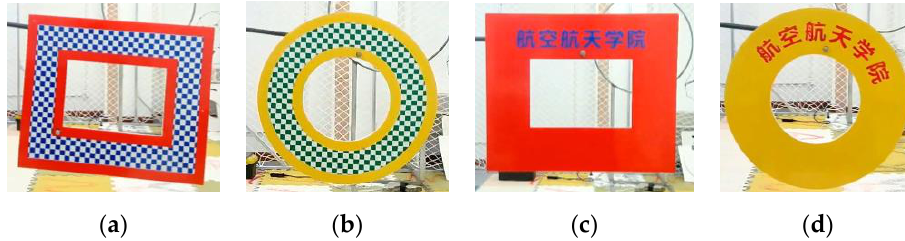
Figure 11. The type of testing targets: ( a ) Rectangle target with grid pattern, ( b ) circular target with grid pattern, ( c ) rectangle monochrome target, and ( d ) circular monochrome target. The size of various targets was about 40 cm.